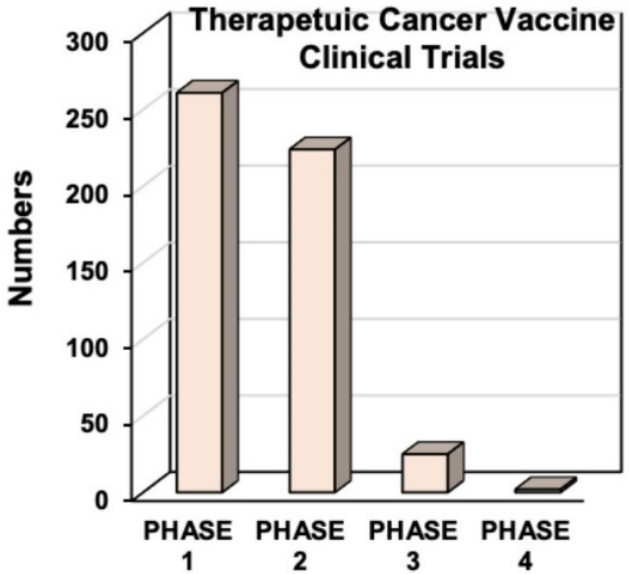
Figure 2. Cancer vaccines in clinical trials. The bar graph shows the frequency of therapeutic cancer vaccines in the USA, divided by phase of the clinical trial. Data were extracted from www.clinicaltrials.gov (accessed on 14 June 2021). Created with https://BioRender.com (accessed on 26 January